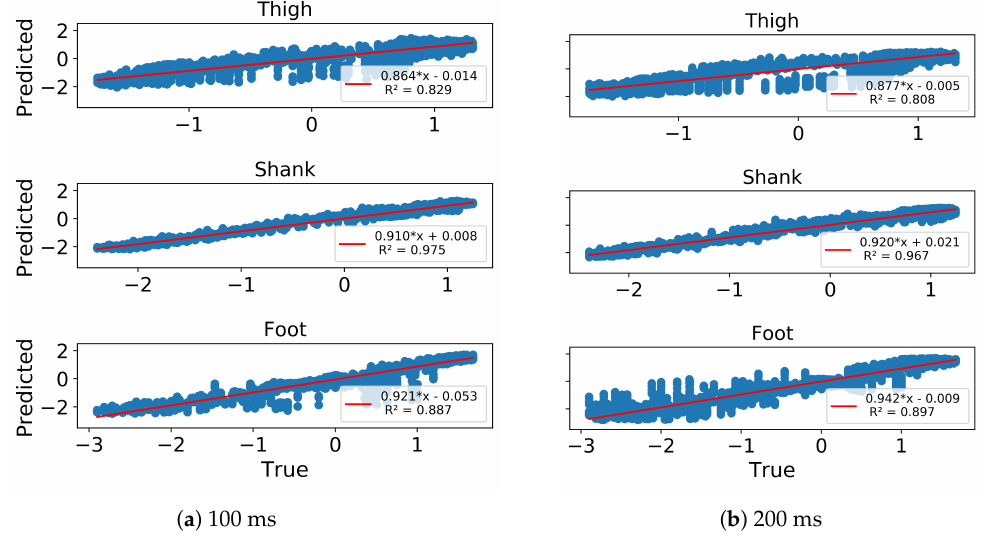
Figure 10. Linear correlation of Predicted ( y -axis) vs. True ( x -axis) z-score normalized angular velocities of ipsilateral thigh, shank and foot of a representative subject in 100 ms ( a ) and 200 ms ( b ) ahead prediction in inter-subject implementation. All angular velocity values shown are normalized to have zero mean and unit